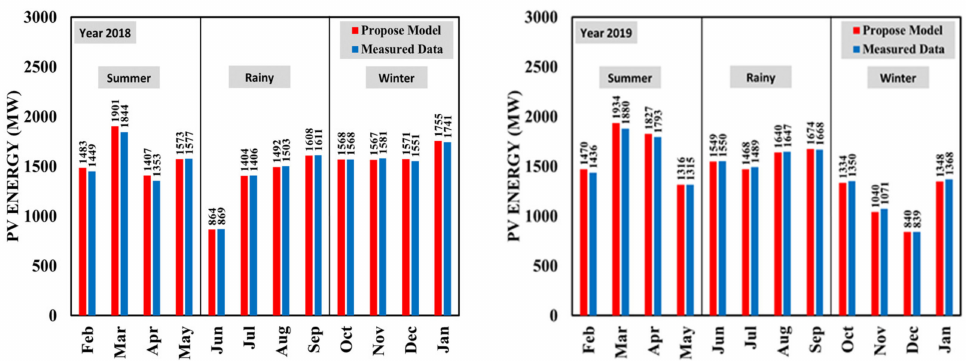
Figure 15. Comparison of the PV energy of the simulated and measured data of the different seasons.